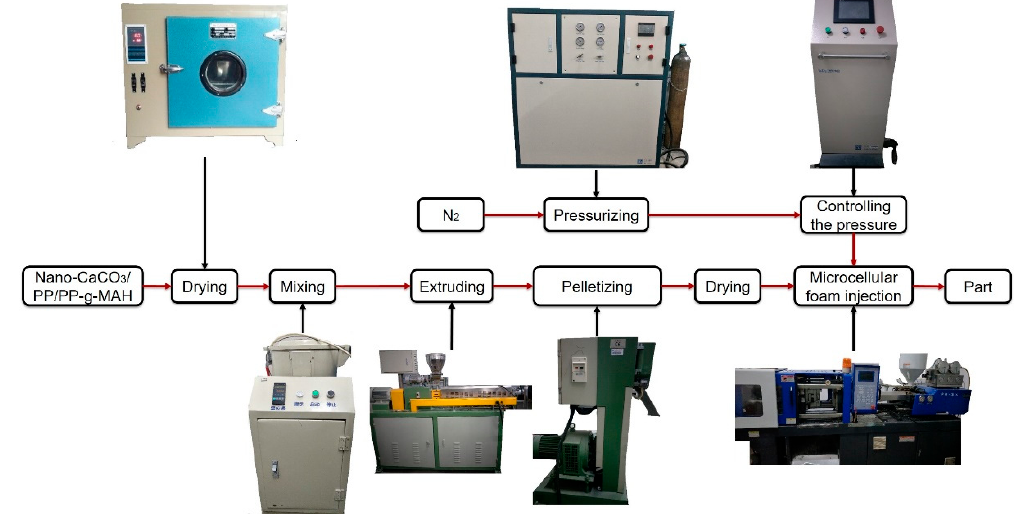
Figure 1. The process flow chart.